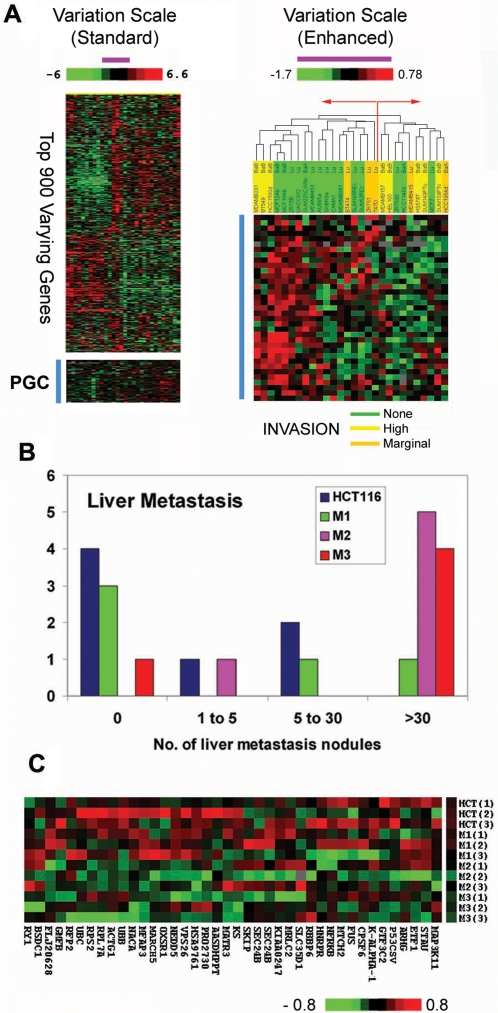
Subtle Alterations in PGC Expression are associated with invasion and metastasis in vitro and in vivo.A) Variation in PGC expression in breast cancer cell lines with differing invasive capacities. (Left) Expression heat-map depicting the range of PGC expression under a normal scale of variation, based on the top 900 varying genes in the data set (−6 to 6.6 fold, top scale bar). Under this normal scale, the PGC genes (blue column) are near black and show minimal expression variation across the cell lines. (Right) Expression heat-map depicting the range of PGC expression under a magnified scale of variation (−1.7 to 0.78 fold, compare purple bars between the left and right heat-maps). This heat-map represents the predominant pattern of gene expression, and does not contain 13 outlier PGC genes (see Figure S2). It worth noting that unsupervised hierarchical clustering based on the entire 48 PGC gene set was used to segregate the cell lines. Chi-square tests comparing the numbers of lines with no metastatic capacities in the two groups were assessed using the top level branch in the clustering tree (red arrows). Invasive capacities of the cell lines (none, high, marginal) were derived from Neve et al., 2006. B) Xenograft model of metastasis. Bar chart depicting the increasing metastatic potential of M1 to M3 cell lines compared to parental HCT116 cells. The x-axis depicts the number of metastatic modules observed per mouse, while the y-axis depicts the number of mice used in each experiment (n = 5 to 7 mice per cell line). C) Expression heat map showing expression of the PGC signature in HCT116, M1, M2, and M3 cell lines, aligned from top to bottom. Three independent biological replicates were profiled for each cell line. Red, black and green squares indicate high, moderate, and low expression respectively. Individual PGC gene names are listed below the heat-map. Note that the range of expression variation across the lines is very small, as shown by the scale-bar (−0.8 to 0.8 fold). This heat-map represents the predominant pattern of gene expression, and does not contain 8 outlier PGC genes (see Figure S2). Once again, the unsupervised hierarchical clustering based on the entire 48 PGC gene set was used to segregate the cell lines.